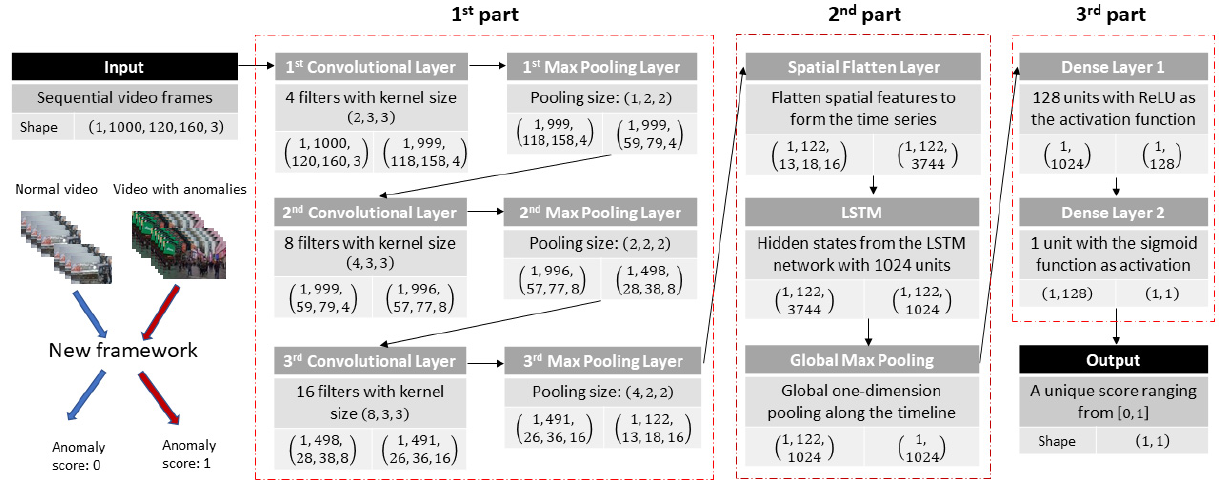
Figure 2. The architecture of the proposed framework. The new framework consists of three parts, each one delineated by a red rectangle: the first one includes three blocks composed of one convolutional layer followed by a pooling layer; the second one is composed of an LSTM network and a global pooling layer, and the third one is a combination of two dense layers to generate the final score. The changes of input and output shapes are illustrated by a video assumed to have 1000 frames of 3 color channels with height and width of 120 and 160 pixels, respectively. The framework does not have restrictions on image size, nor the number of frames; it takes a video as an integral input and outputs a unique score to indicate whether it contains anomalies.